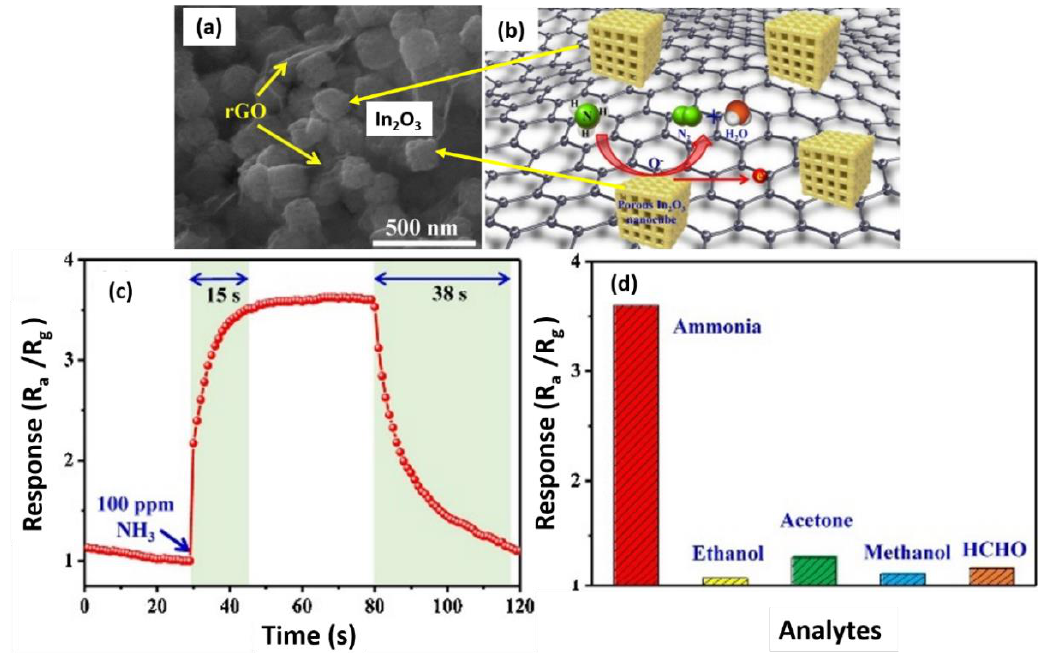
Figure 9. ( a ) SEM image of the rGO/In 2 O 3 nanocomposite, ( b ) The schematic diagram of the rGO/In 2 O 3 nanocomposite detecting the NH 3 , ( c ) room temperature response and recovery time of the rGO/In 2 O 3 nanocomposite up to 100 ppm NH 3 , and ( d ) rGO/In 2 O 3 sensor responses to 100ppm of various gases at room temperature. Reproduced from ref.